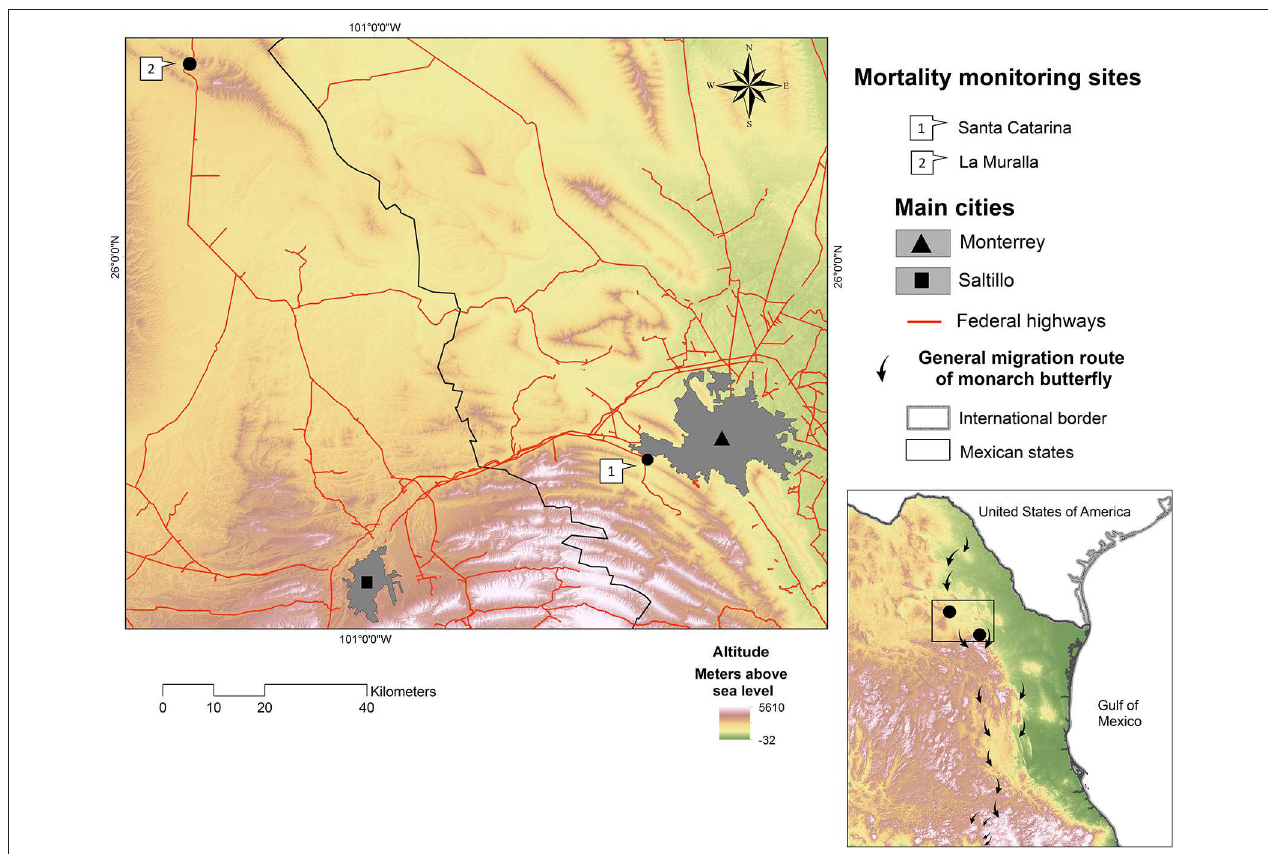
FIGURE 1 | Location of the study area used during the autumn migration of 2018 with the two highway crossings indicated. Arrows indicate approximate autumn migration route through northeastern